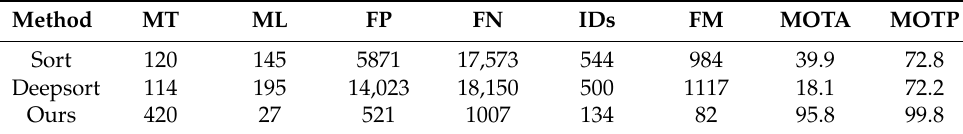
Table 6. Comparison of tracking metrics on MOT15 dataset and deepsort algorithm (continued).